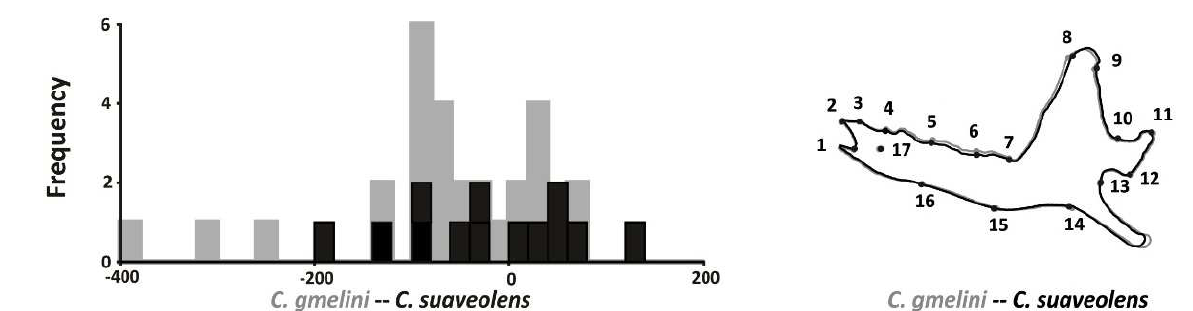
FIGURE 4. Discriminant analysis (DA) of mean shape in mandible between gmelini (grey) and suaveolens (black) from northern Iran.